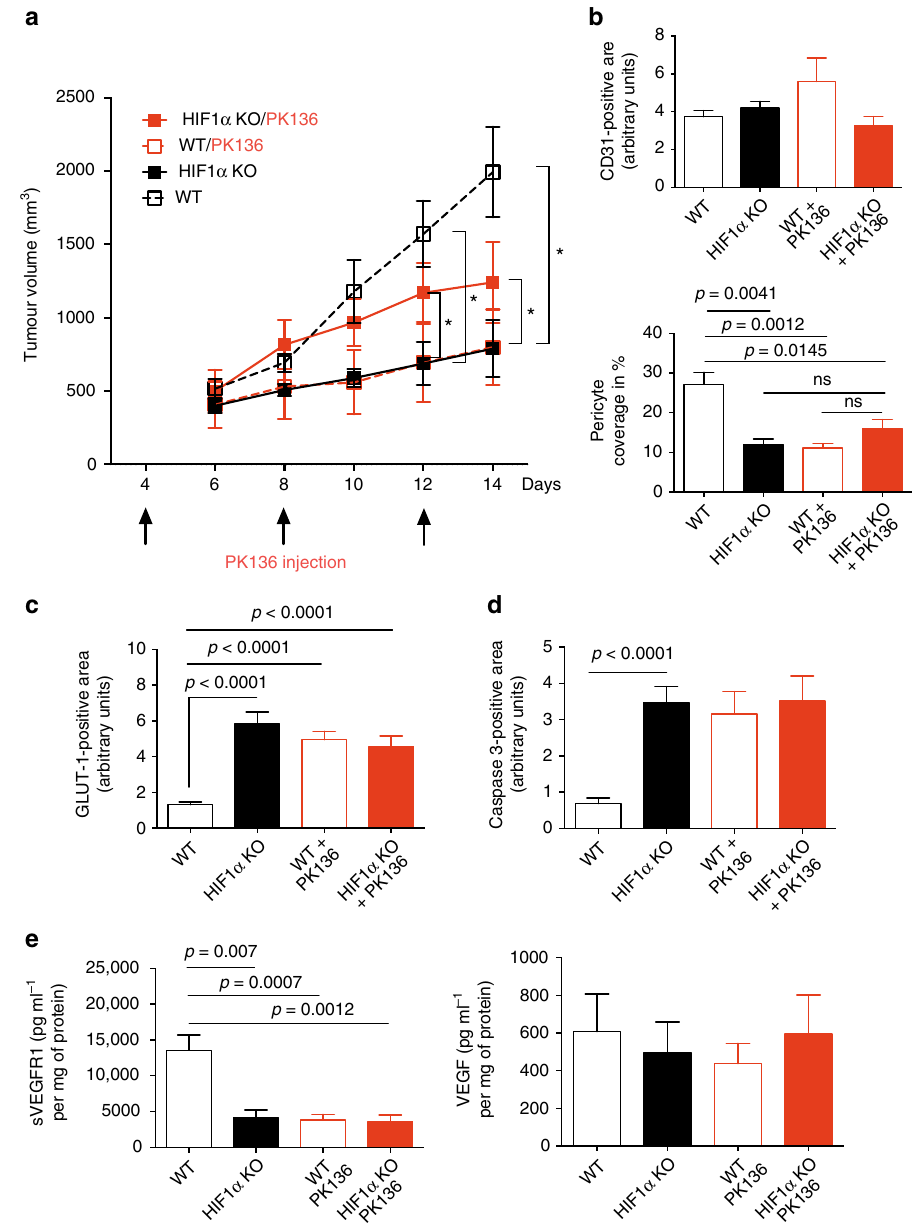
Fig. 5 NK cell depletion recapitulates the HIF-1 α KO phenotype. a Tumour volume analysis of MC38 isografts implanted in WT and HIF-1 α KO mice injected i.p. with anti-NK1.1 monoclonal antibody PK136 (4 mg per kg body weight) at day 4, 8, and 12. Control mice received i.p. injections of 100 μ l PBS. b Quantitative analysis of CD31-positive endothelial cells and pericyte coverage as assessed by α -SMA/CD31 co-localisation at endpoint, day 14. c Quantitative analysis of hypoxic tumour areas with the speci fi c marker GLUT1 at endpoint, day 14. d Quantitative analysis of caspase-3-positive areas at endpoint, day 14. e Determination of levels of sVEGFR1 and VEGF protein in MC38 isografts implanted in WT and HIF-1 α KO mice by ELISA at endpoint, day 14 ( n = 9 for WT group; n = 5 for HIF-1 α KO group; n = 8 for PK136 depleted WT group; n = 7 for PK136 depleted HIF-1 α KO group). Statistical signi fi cance was determined by an unpaired Student ’ s t -test or one-way analysis of variance, where appropriate. Bars represent mean values; error bars indicate the s.e.m. Statistical signi fi cance is indicated as * P < 0.05, ** P < 0.01, and *** P < 0.001 intratumoural injection of the recombinant protein. Alternatively, contrast, in HIF-1 α KO mice, delivery of recombinant sVEGFR1 we employed a sVEGFR1 encoding plasmid on day 6 (when tumour rescued growth of MC38 tumours (Fig. 4a), along with an increase growth kinetics start to differ between genotypes, see Figs. 2a, 4a), 8, in pericyte coverage (Fig. 4b) and tumour oxygenation (Fig. 4c) as 10, and 12 post tumour inoculation (Fig. 4a and Supplementary well as decrease in tumour cell death (Fig. 4d). Noteworthy, Fig. 4a). In tumour bearing WT mice, sVEGFR1 supplementation sVEGFR1 supplementation failed to rescue the in fi ltration defect of increased pericyte coverage of tumour blood vessels, reminiscent of HIF-1 α KO NK cells and did not alter the in fi ltration of other vascular normalisation 24 (Fig. 4b). Yet, this change in vascular immune cell subsets (Supplementary Fig. 4b). These data links morphology did not impact on tumour oxygenation (Fig. 4c), reduced tumour volumes to low intratumoural sVEGFR1 and non- tumour cell death (Fig. 4d) or overall tumour growth (Fig. 4a). In productive angiogenesis. NATURE COMMUNICATIONS | 8: 1597 | DOI: 10.1038/s41467-017-01599-w |